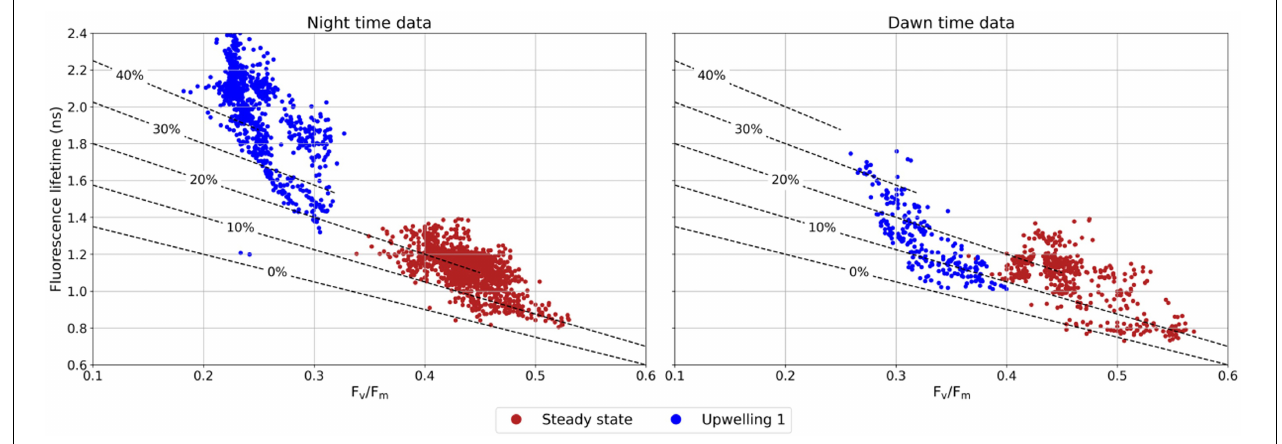
FIGURE 5 | Relationship between F v /F m and fluorescence lifetime along the steady state and uw1. Left- data collected during the night, right- data collected at dawn. In both cases NPQ is assumed to be nil, thereby removing the nonlinear effect of NPQ on the otherwise linear relationship between F v /F m and fluorescence lifetime (Lin et al., 2016). Dashed lines indicate the fraction of uncoupled reaction centers. 0% dashed lines represents the modeled linear dependency of F v /F m and fluorescence lifetime (Butler, 1978). 10–40% dashed lines represent the dependency of these parameters in detached antenna PSII reaction centers